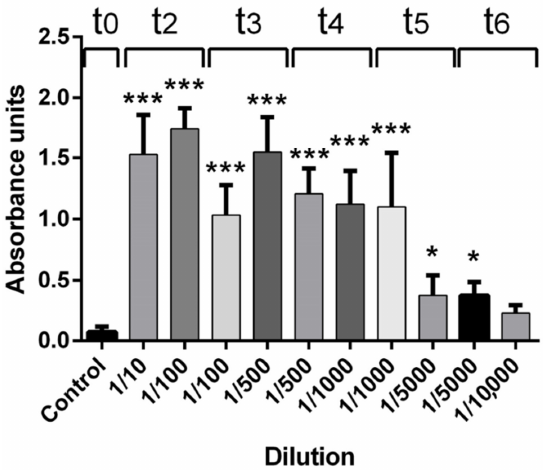
Figure 4. IgG quantification after pooling the absorbance of dilutions from all rabbits. Antibody production in all immunized rabbits by dilution after each immunization period after pooling absorbance of each dilution. Three asterisks indicate a significant difference with a p < 0.001 compared with the control group (t0). One asterisk indicates a significant difference with a p < 0.05 compared to the control group (t0). Absorbance recorded at 450 nm.